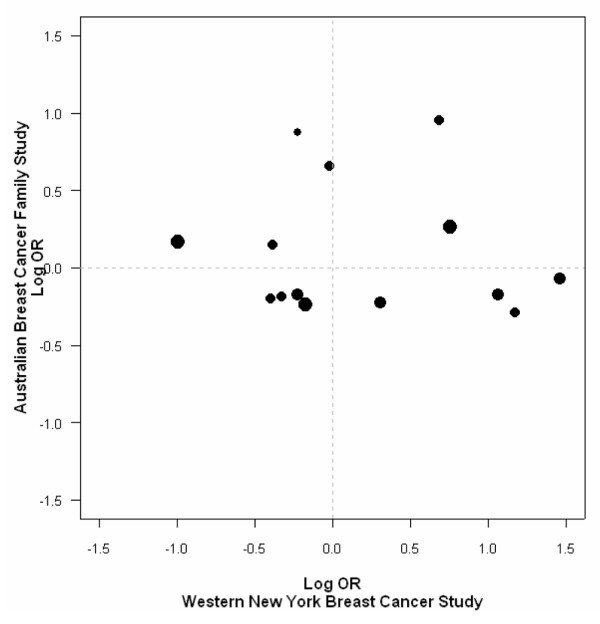
Log odds ratio estimates versus corresponding estimates from the Western New York Breast Cancer Study.